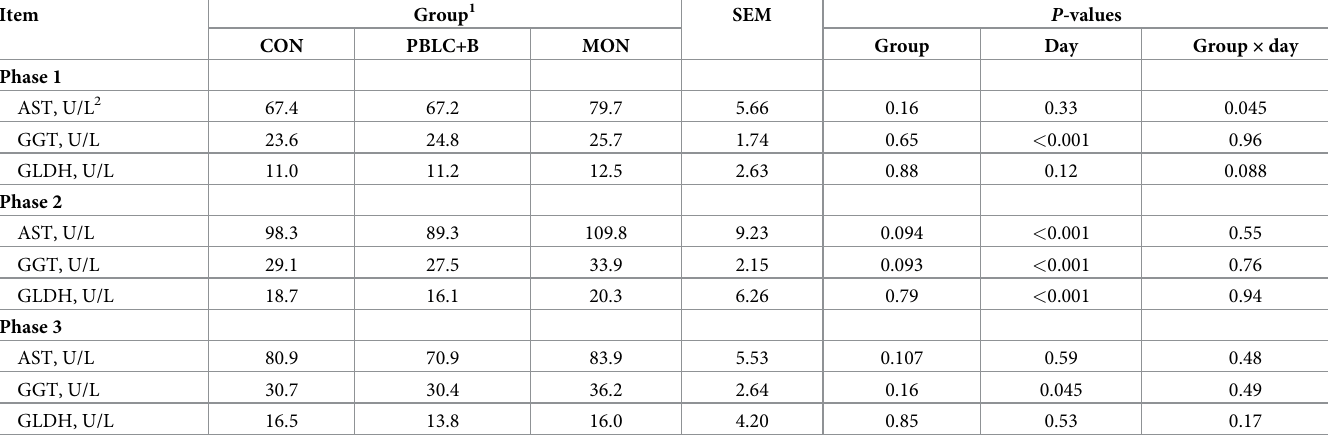
Phase 1: from d -21 to d -1 relative to parturition; Phase 2: from d 1 to d 37 relative to parturition; Phase 3: from d 38 to d 58 relative to parturition. AST =